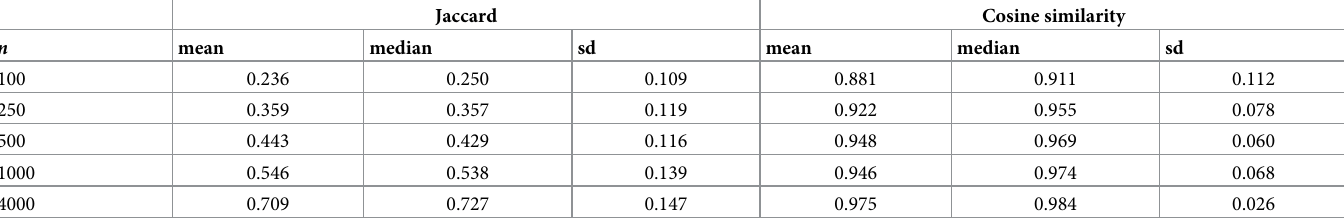
Table 4. Mean, median, and standard deviation (over 50 samplings of discovery/validation data) of a) the Jaccard index which compares the set of hubs obtained on the discovery data with the set of hubs on the validation data, and b) the cosine similarity which compares these sets of hubs, but on the level of families.